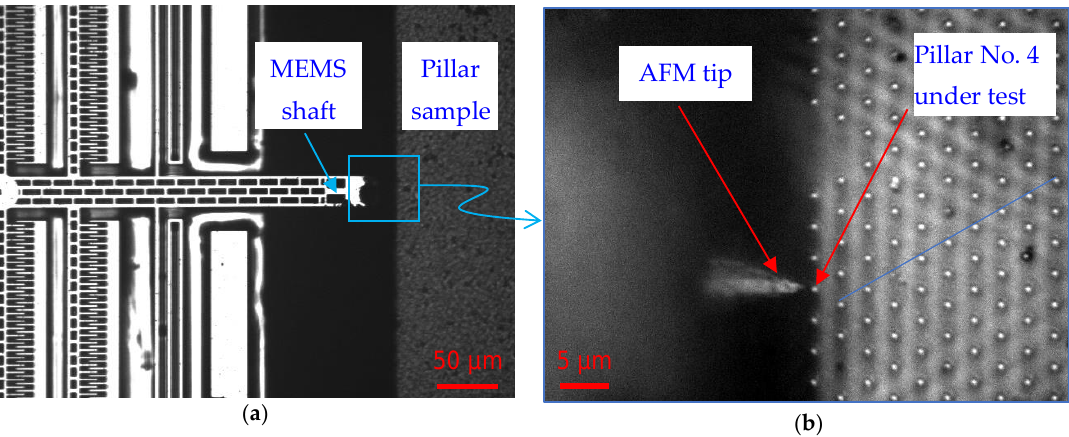
Figure 6. Nanopillars under measurement: ( a ) Auxiliary optical microscope (5x, NA = 0.13) image of the MEMS-SPM and the silicon nanopillar sample (top view); ( b ) detailed view of the AFM tip and the pillars under nanomechanical measurement with an Olympus objective (80x, NA = 0.75).